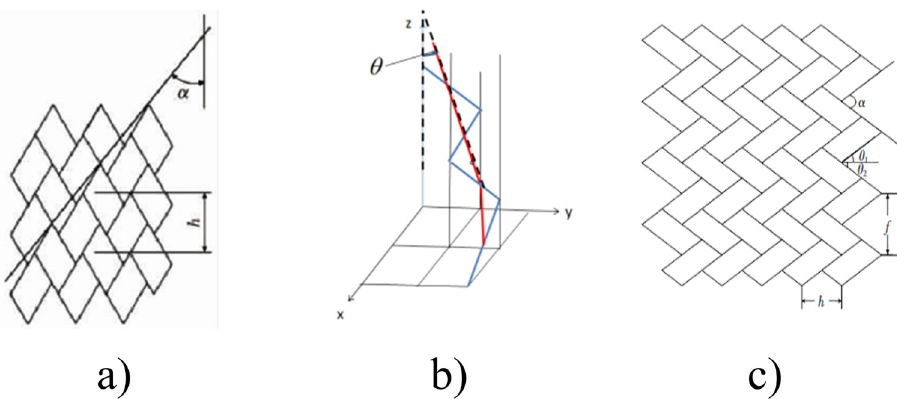
Figure 1: De fi nition of weaving angle: ( a ) surface braid angle, ( b ) body braid angle, and ( c ) h is the fl ower pitch length, f is the fl ower pitch width.